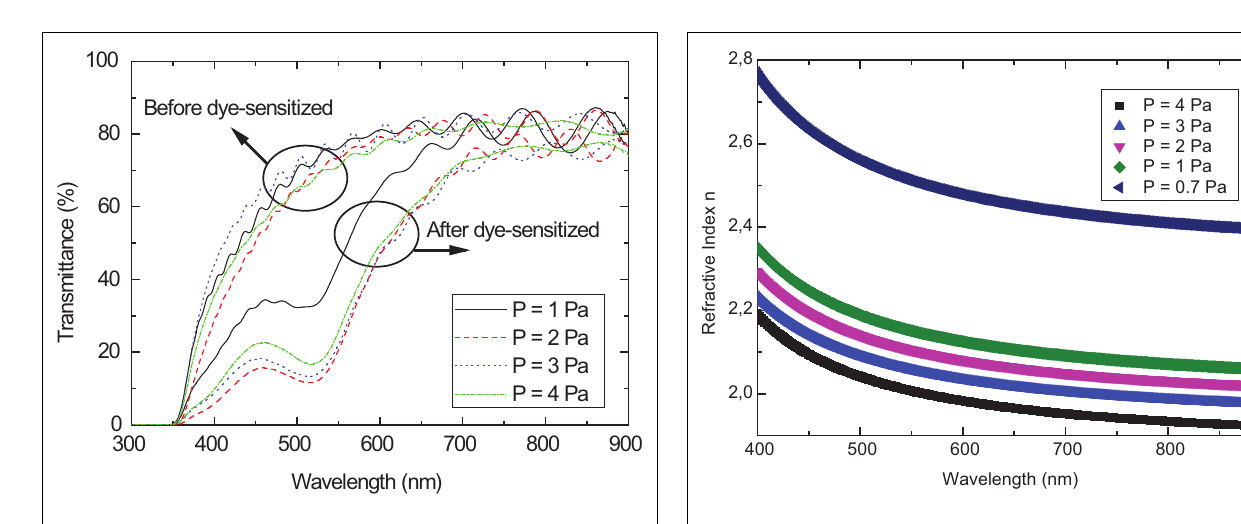
FIGURE 8 |The transmittance of theTiO 2 nanorods prepared at different sputtering pressures before and after dye-sensitized .